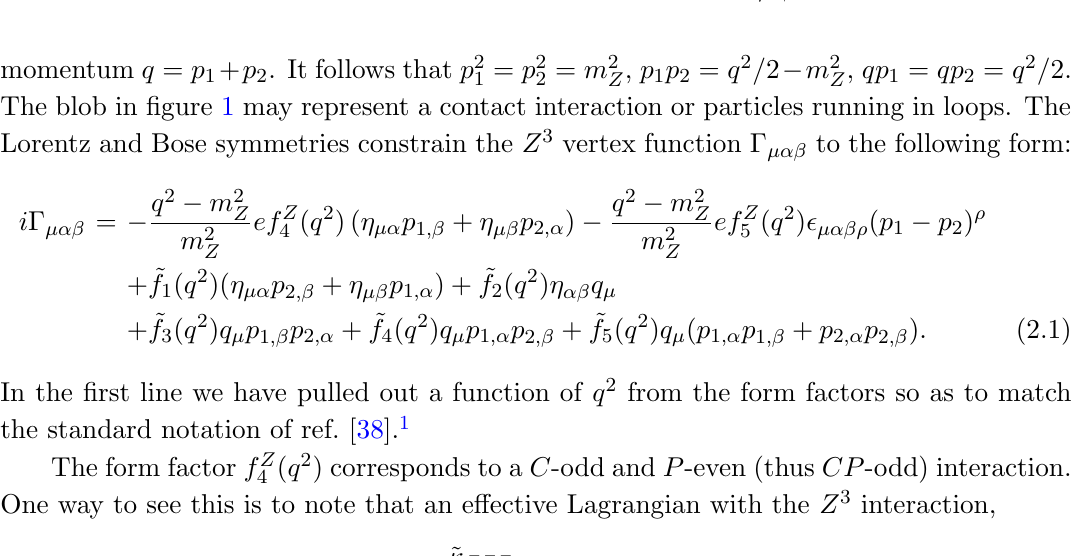
(cid:22)(cid:11)(cid:12)